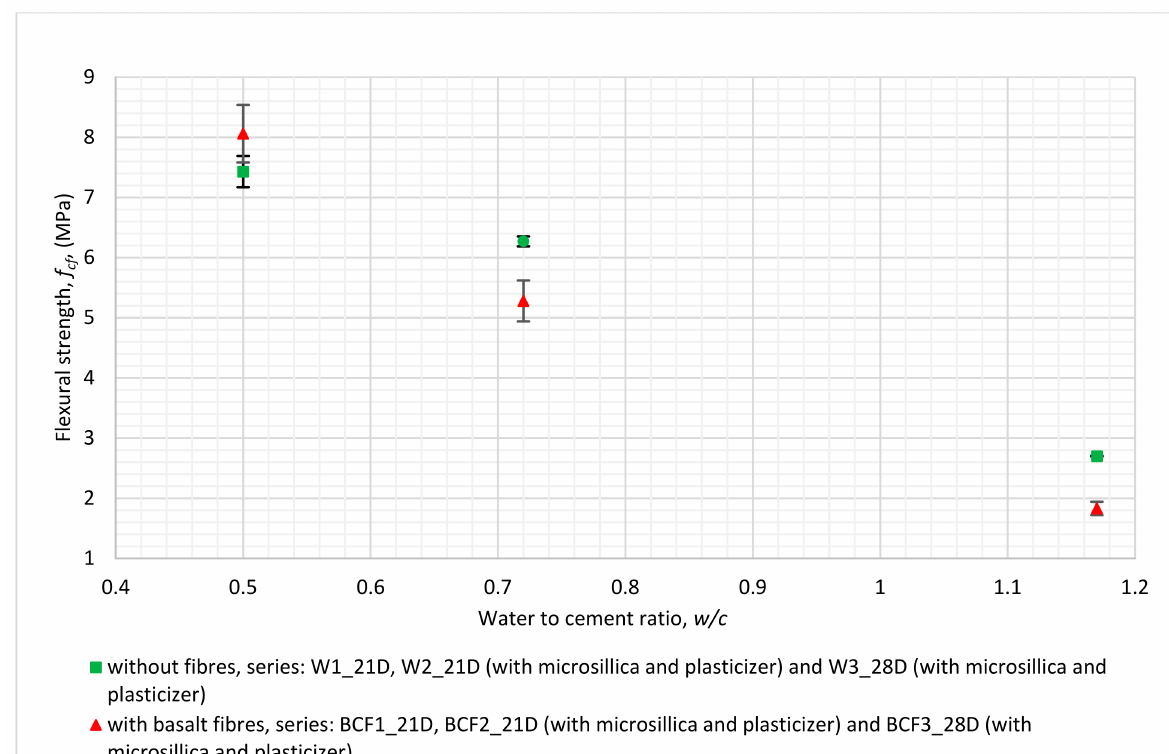
Figure 4. Relation between w/c ratio and flexural strength for series revealing the influence of mixture proportions (for detailed descriptions of mixture proportions, see Table